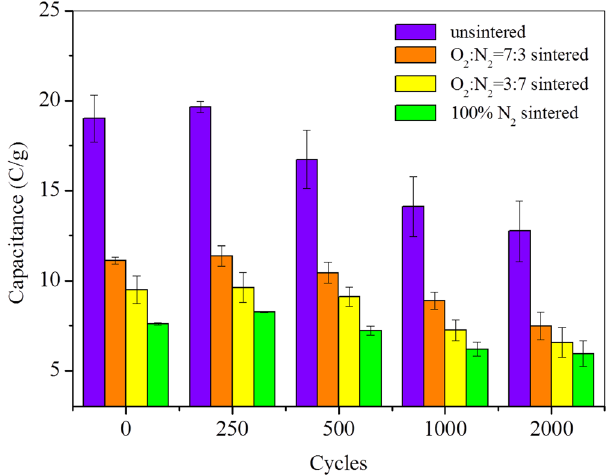
Figure 6. Equivalent electron capacities of CB electrodes with different charging-discharging